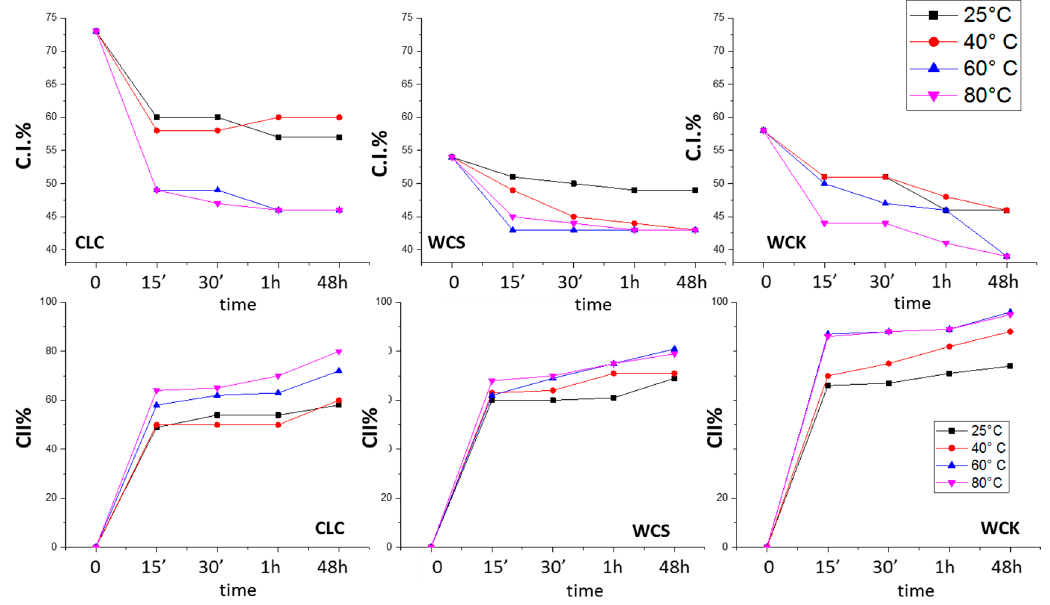
Figure5. Trendsinthecrystallinityindex(C.I.%, toprow)andconversion(CII%, bottomrow)ofcellulose Figure 5. Trends in the crystallinity index (C.I.%, top row) and conversion (CII%, bottom row) of I to cellulose II at di ff erent mercerization times for CLC, WCS and WCK at di ff erent temperatures. cellulose I to cellulose II at different mercerization times for CLC, WCS and WCK at different temperatures.